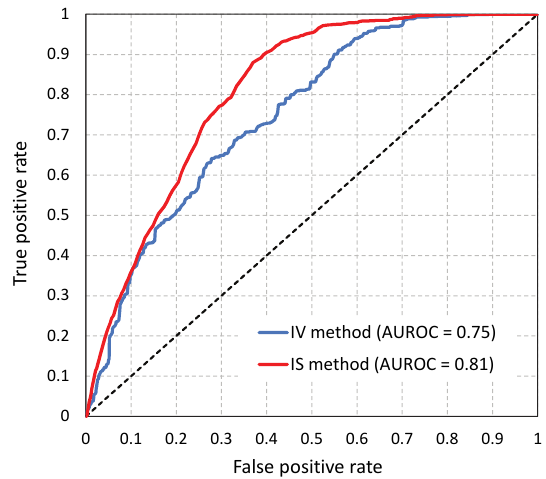
Figure 7. ROC curves based on independent validation of IV and IS shallow slide susceptibility